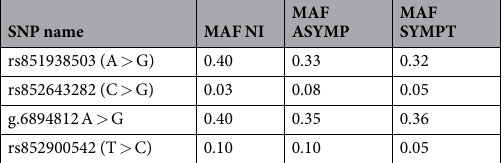
Table 3. Minor allele frequencies for each of the 4 vitamin D receptor SNPs genotyped in the study. MAF: Minor allele frequency; NI: non-infected dogs, ASYMP: the group of asymptomatic dogs, SYMPT: group of dogs suffering clinical leishmaniasis. In the SNP name column cells, the major and the minor alleles of the SNPs with an rs identifier are indicated between brackets.